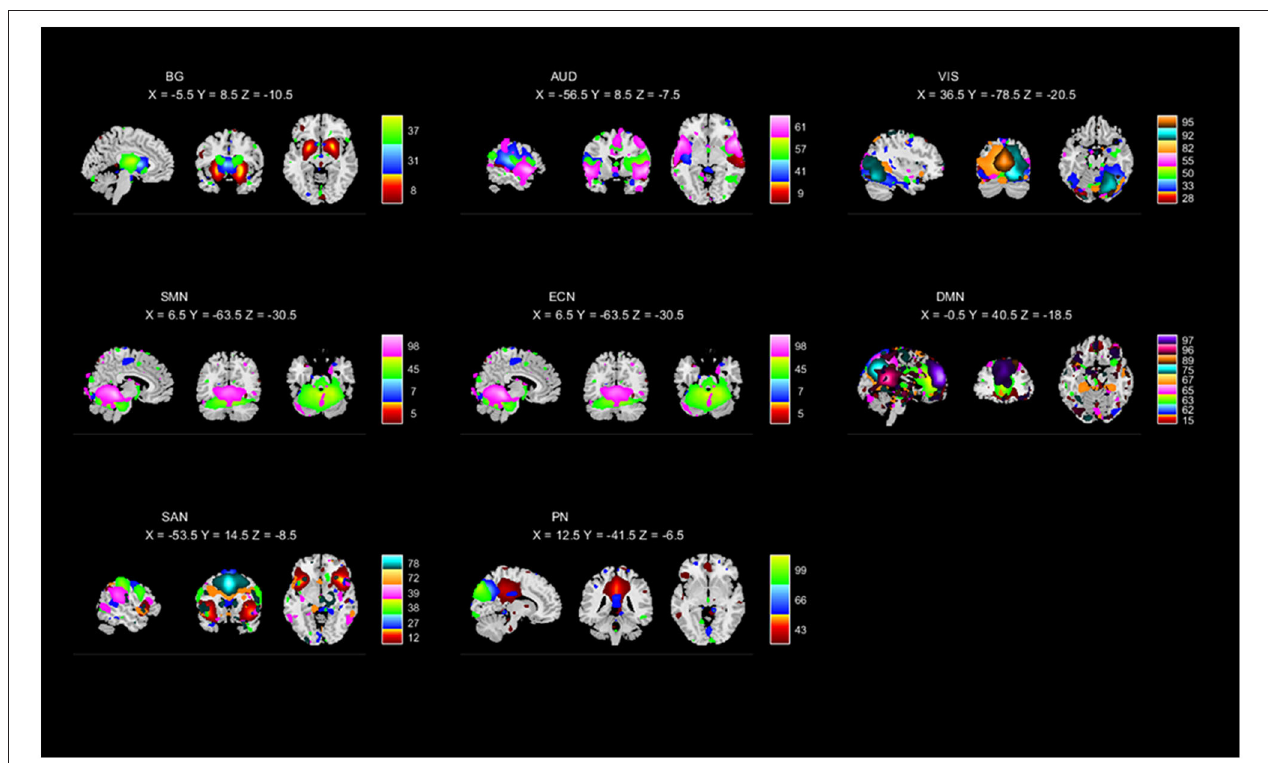
FIGURE 1 | Independent components (ICs; n = 42) identified by the group ICA. The IC spatial maps were divided into eight functional networks (namely, BG, AUD, VIS, SMN, ECN, DMN, SAN, and